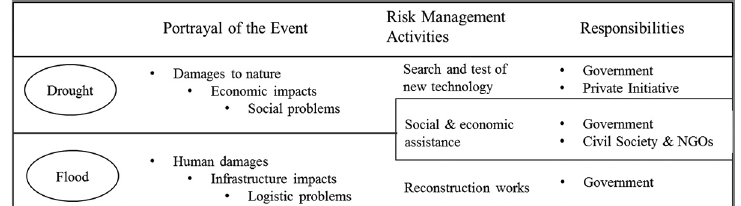
Figure 5. Portrayal of the